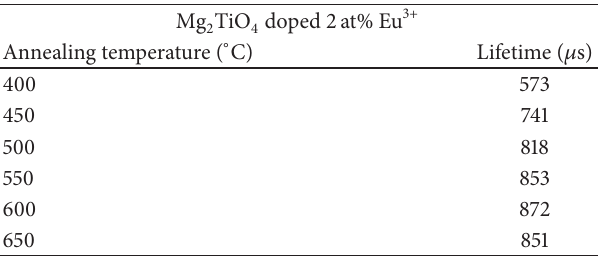
Table 1: Lifetimes of the 5 D nanoparticles prepared at different